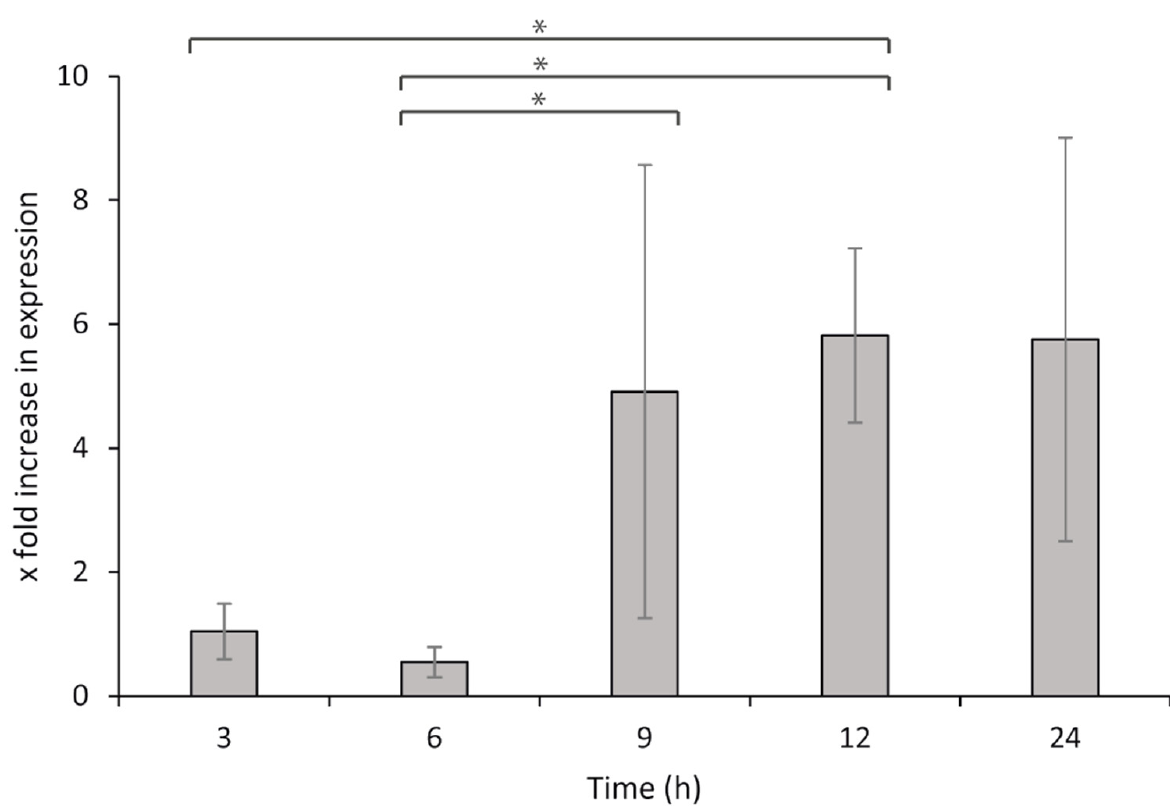
Figure 6. Fold increase in relative expression levels of < hia > in P. atlantica (UiBP1-2013) over time in the presence of lumpsucker head kidney leucocytes, compared to bacteria not exposed to HKL. Error bars represent standard deviation ( n = 4). Asterisks represent significant differences in expression between the time points indicated by square brackets.